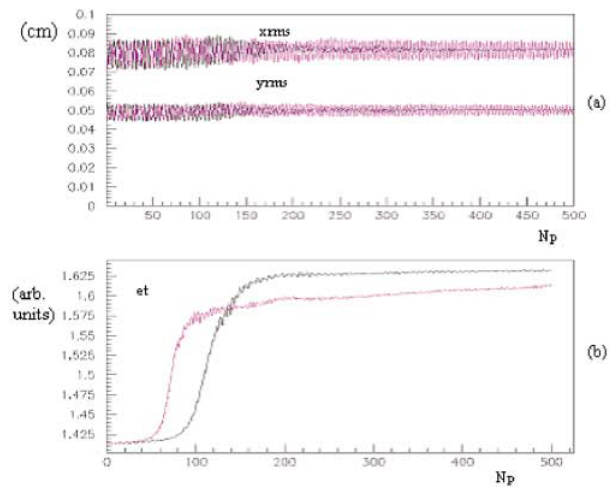
FIG. 1. (Color) (a) rms envelope oscillations with initial K-V distribution for s (cid:5) s 0 (cid:2) 0.55 and (b) the total emittance varia- tion e t vs the periodic cell number Np . The black line refers to the odd mode and the magenta line to the even mode. tron tune shift on the beam particles. In general, it is an incoherent tune shift causing an increase of the betatron frequency spread. However, in the case of a K-V distri- bution, the space charge force is linear due to uniform spatial distribution. As a consequence, the space charge tune shift is uniform; that is, all the particles will oscil- late with the same shifted betatron frequency. No increase in betatron spectrum should be observed as long as this